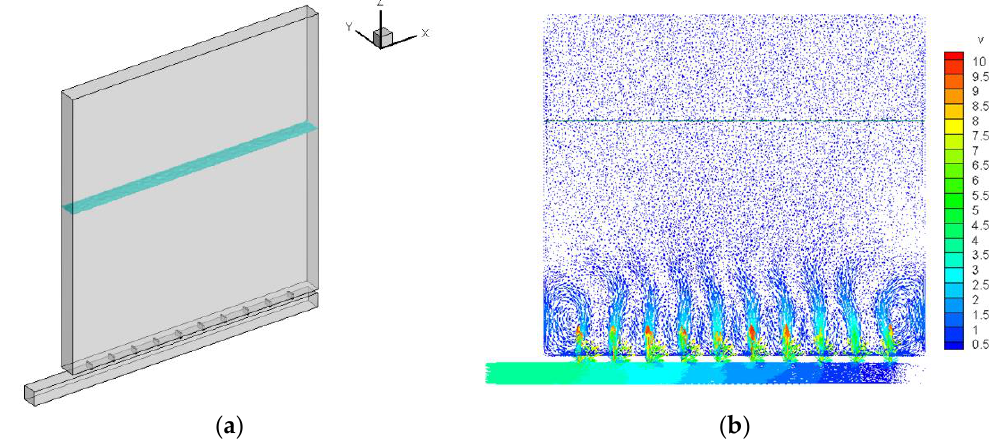
Figure 14. Hydrodynamic characteristics of the longitudinal culvert filling–emptying system under the condition of a 150 m lifting height: ( a ) the diagram of the vertical shaft water level and ( b ) longitudinal profile velocity.